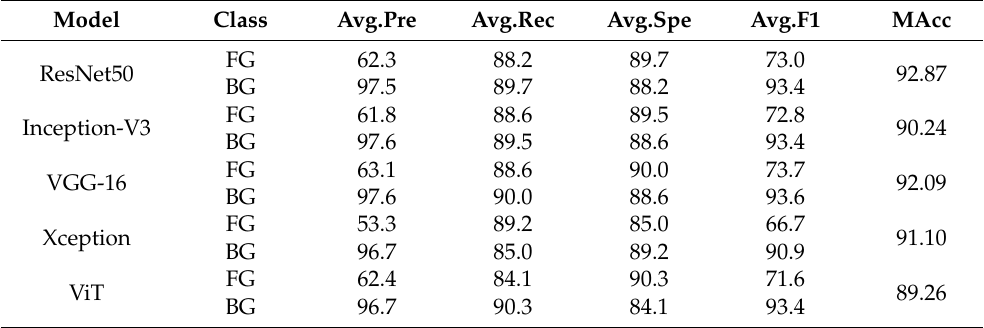
Table 4. Classification performance of models of five-fold cross-validation experiment on validation set of 8 × 8 pixels patches. MAcc (Max Acc), FG (foreground) and BG (background) (In [%]). Model